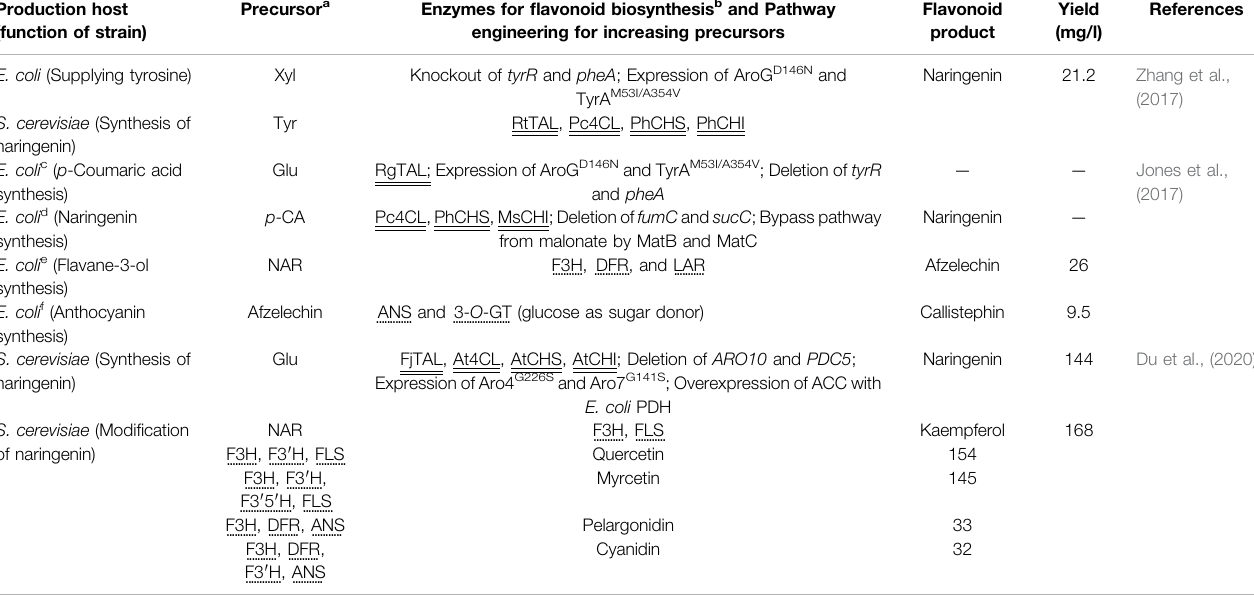
TABLE 2 | Co-culturing system for production of naringenin and its derivatives. Production host (function of strain)